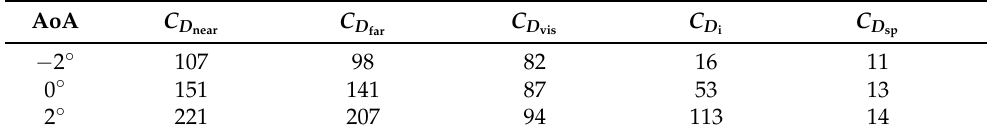
the drag polars with spurious drag detection; induced drag computed by Maskell’s